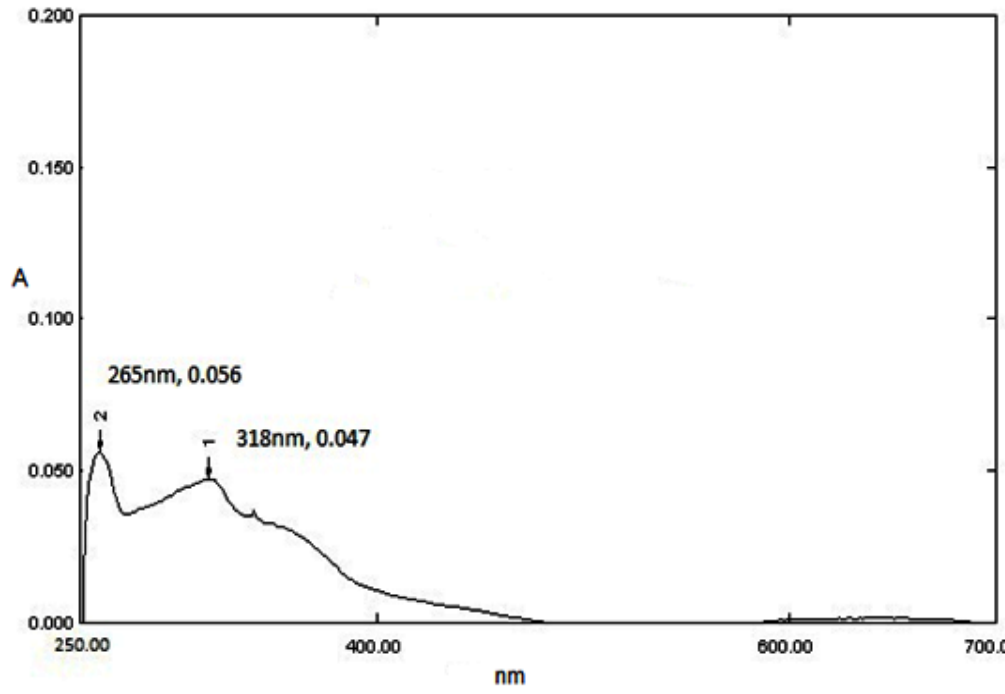
Figure S15: UV/Visible spectrum of Schiff base polyether P o HONPD